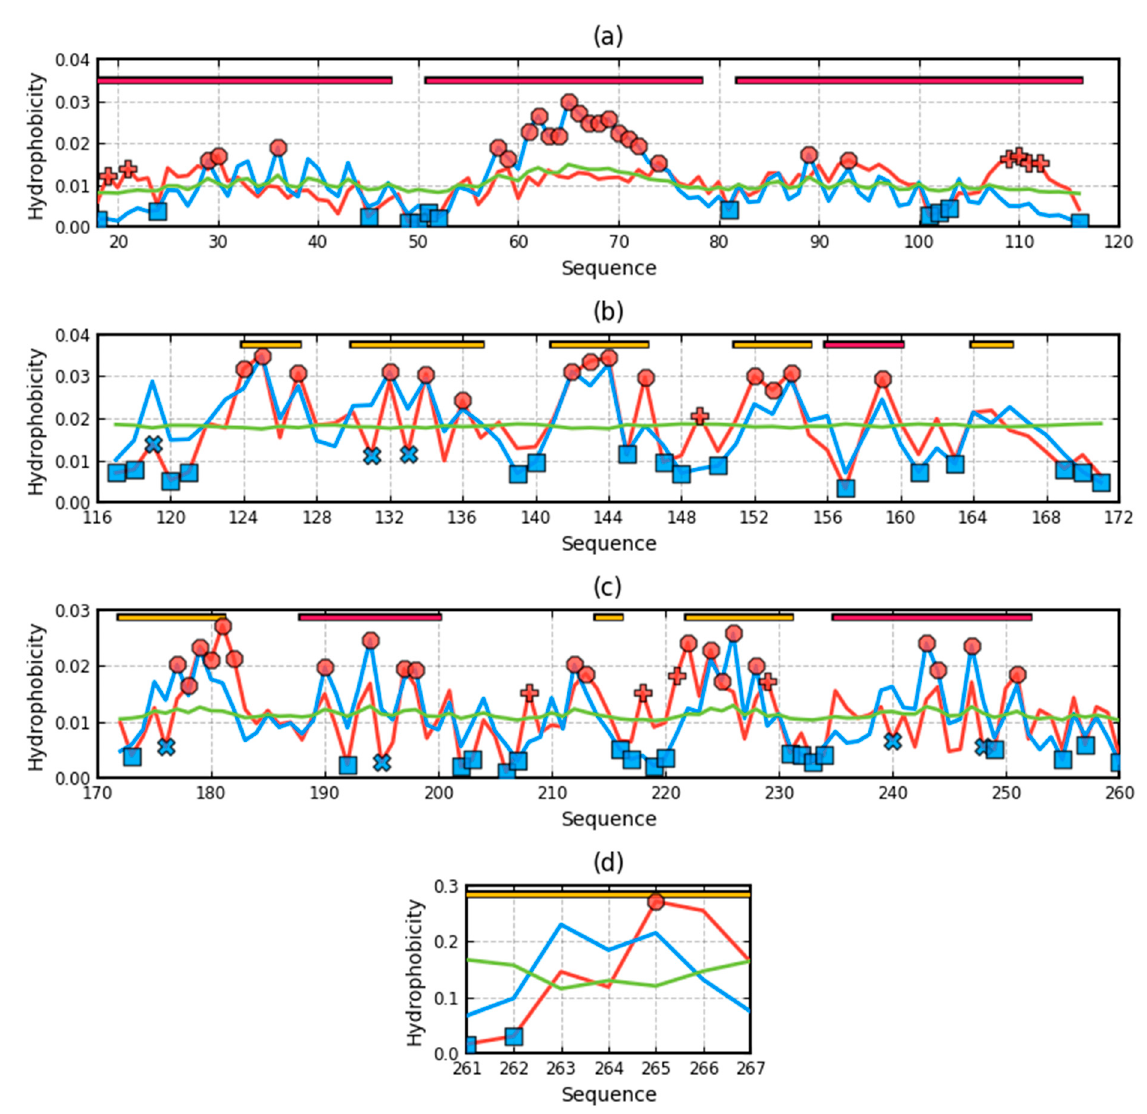
Figure 8. Profiles T, O, and M in Romains of 4HW9-3D Gauss function generated for each domain individually ( a )—dom1, ( b )—dom2, ( c )—dom3, ( d )—dom4—beta-barrel. T distribution—blue, O distribution—red, M distribution—green. Top bars: yellow—beta-structure, yellow—helix. Red circles—residues potentially engaged in hydrophobic core construction, blue “X”—residues of hydrophobicity deficiency—here residues engaged in channel construction, red “+”—hydrophobicity excess potentially engaged in protein-protein complexation—here—the interaction with membrane. The blue squares—residues on the surface representing low hydrophobicity—a status accordant with FOD criteria.